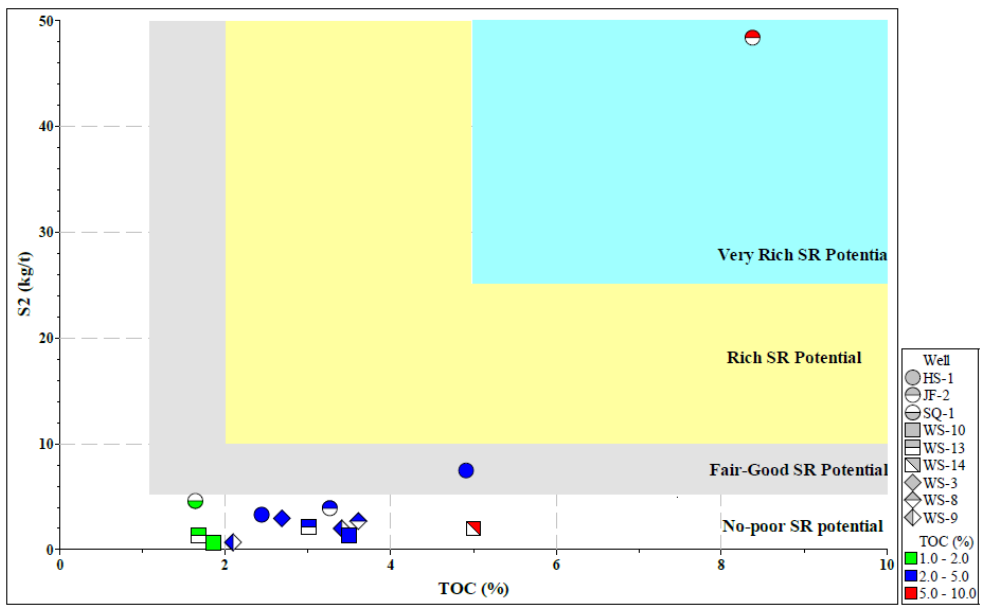
Figure 7. Total Organic Carbon (TOC)-S 2 cross plot for characterizing source rock potential.